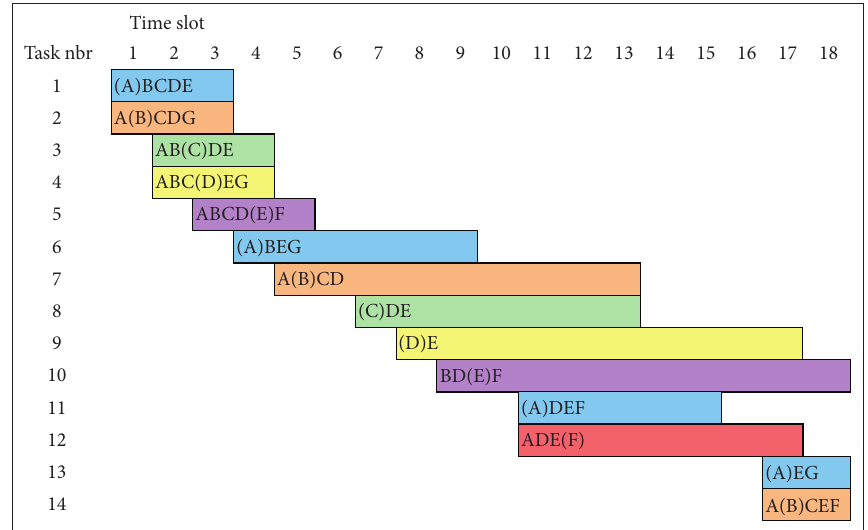
Figure 1: A simplified instance of SMPTSP and a feasible solution to the instance. The letters indicate employees able to carry out a task. An employee assigned to carry out a task is denoted by parentheses (employee G has no tasks). The colors indicate generated